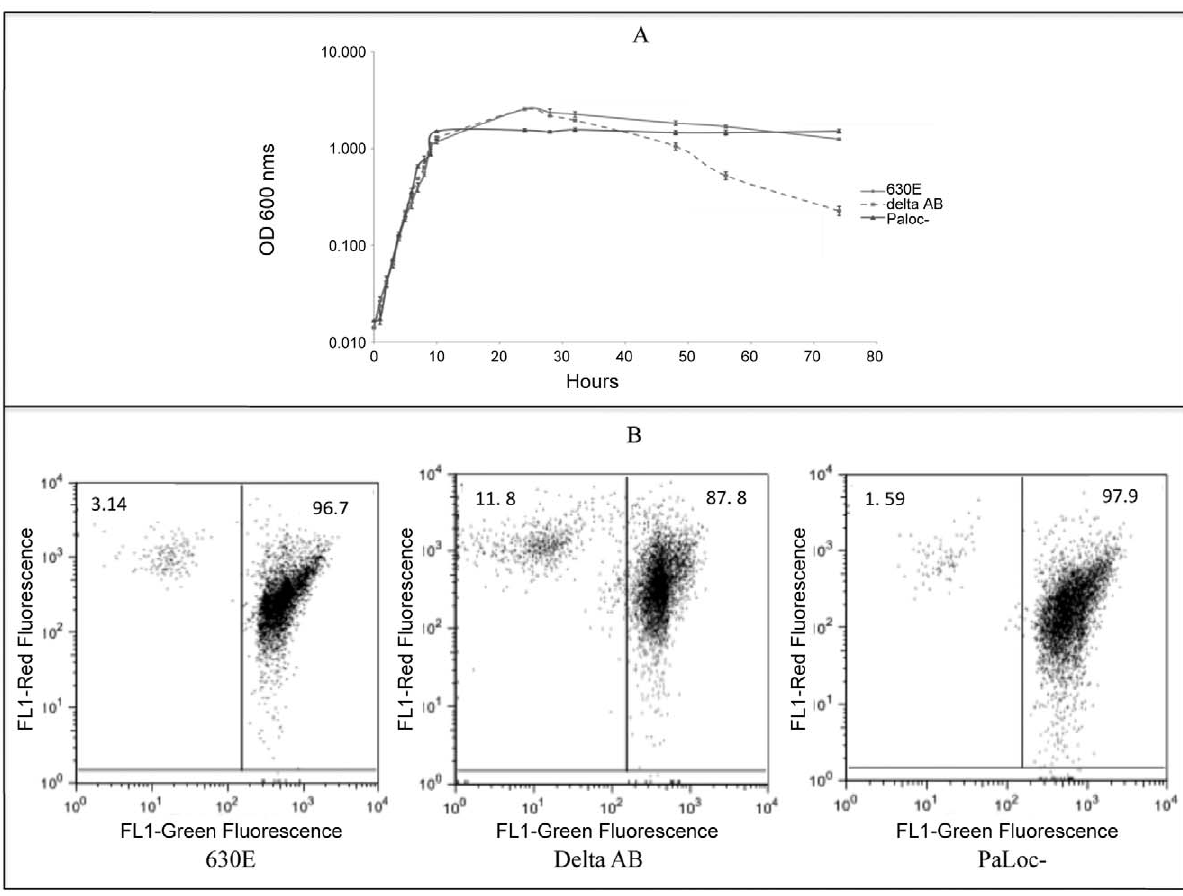
Figure 6. Cell lysis in C.difficile A 2 B 2 double mutant strain. A. Growth curves of strains, 630A 2 B 2 ( C. difficile tcd AB double mutant), 630E (wild type) and a PaLoc negative strain. C. difficile strains were grown in TY medium in a 100 ml Erlenmeyer flask and the optical density at 600 nms was recorded at regular time interval. B. Bacterial cultures were harvested at a 30 hour time point for FACS analysis after propidium iodide (PI) and SYTO staining. lysis (Figure 8C) compared to the rapid lysis phenotype of tcdEM1 expressed from the l S RBS (Figure 8A).